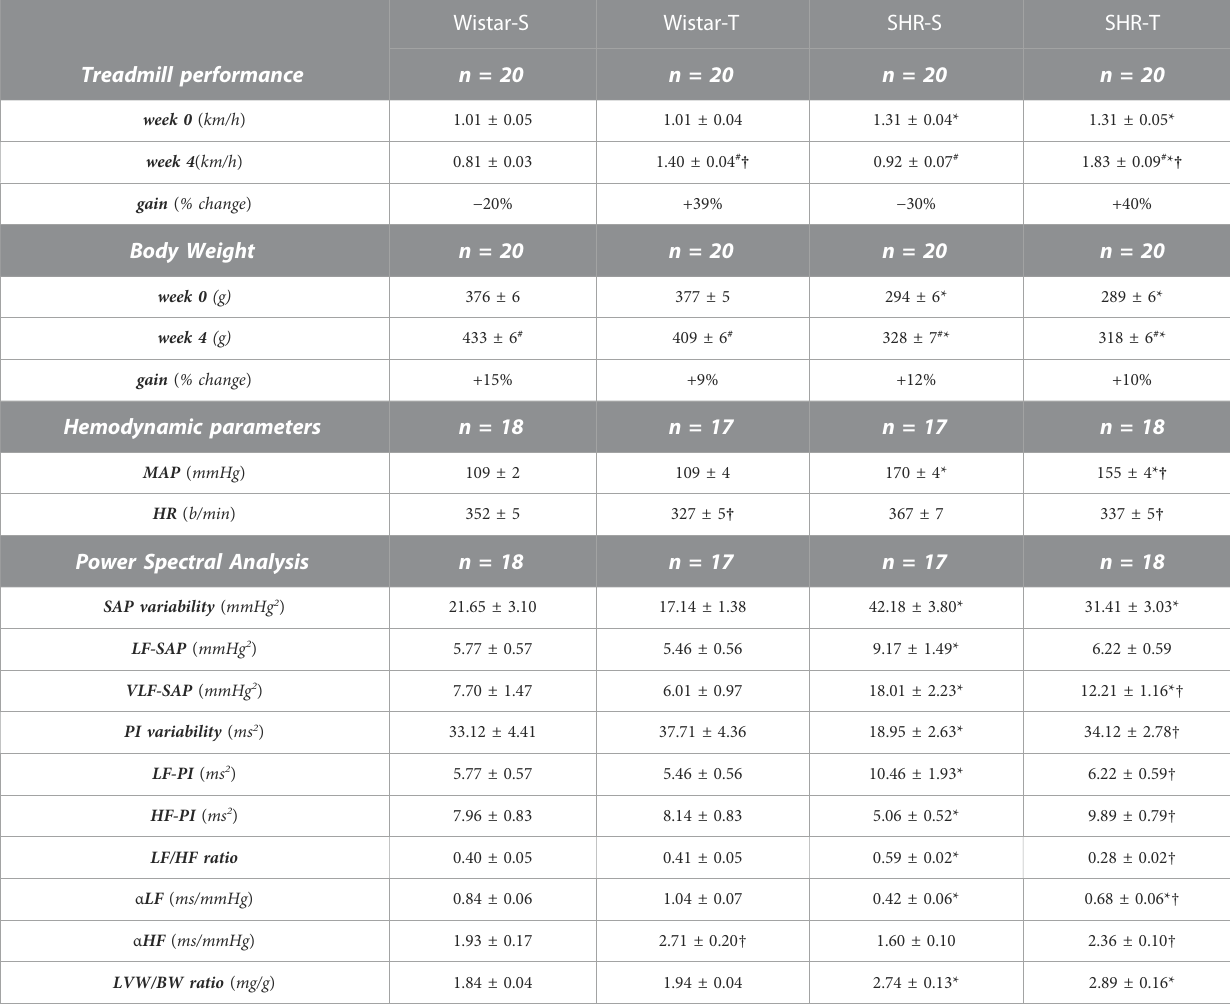
TABLE 1 Treadmill performance and body weight during experimental protocols, resting hemodynamic parameters, autonomic modulation and cardiac hypertrophy at the end of protocols in sedentary (S) and trained (T) Wistar and spontaneously hypertensive rats